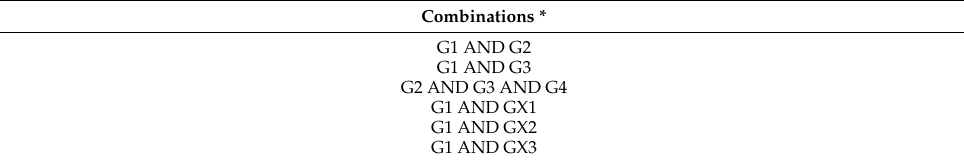
Table 2. Keyword search